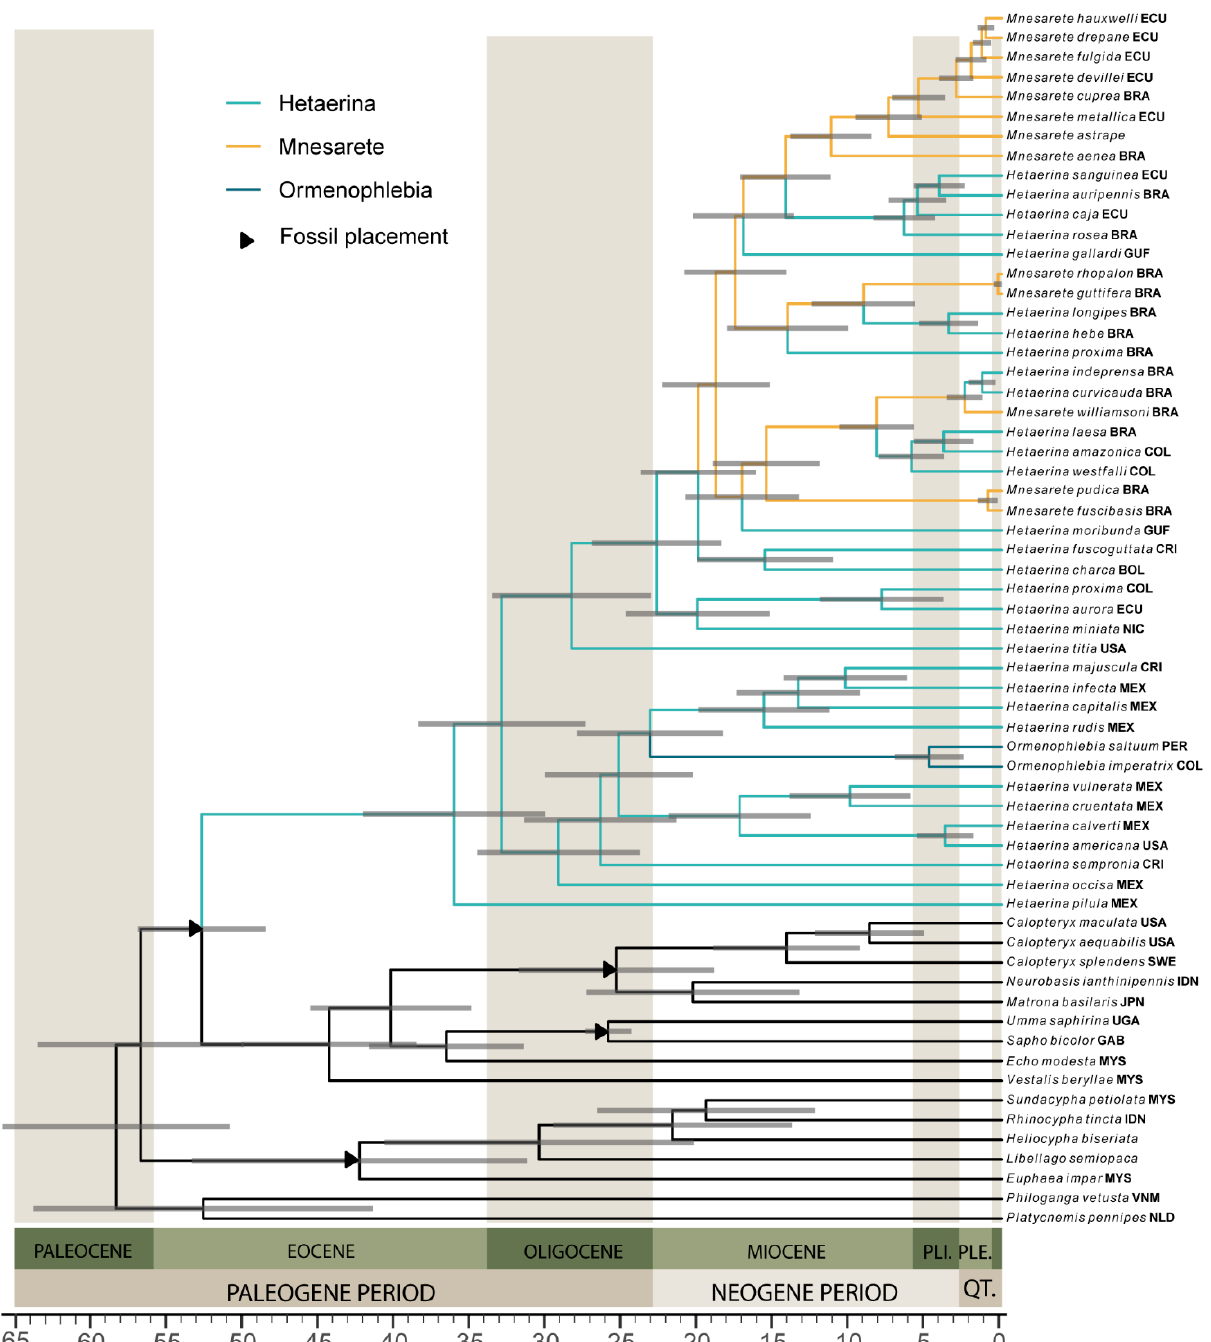
Figure 5 . Phylogenetic relationships and time calibration of Hetaerininae. Bayesian time-calibrated tree estimated in BEAST2 v2.6.6 with median node ages, 95% high probability density (HPD) intervals for each node displayed in gray bars. Fossil-calibrated nodes represented with black triangles.